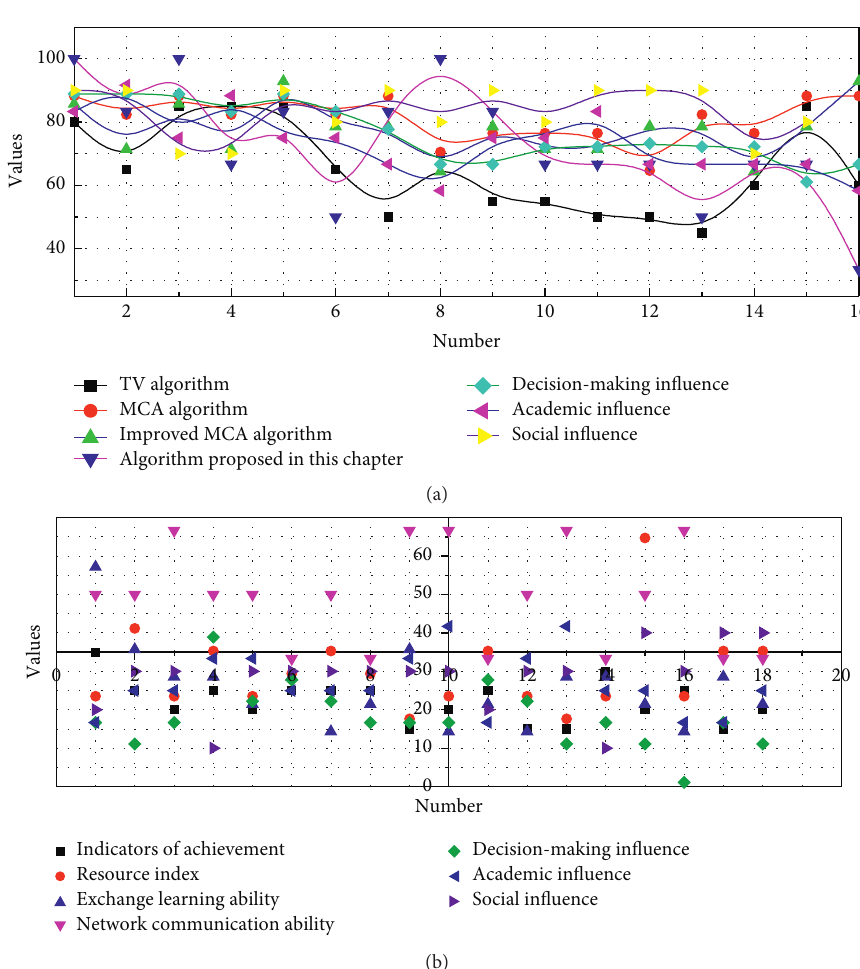
Figure 7: Experimental restoration of large defective areas of frescoes 1 objective evaluation score.